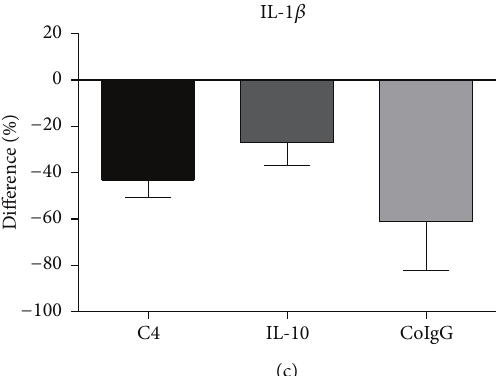
Figure 5: Butyrate transcriptionally influences cytokine responses to Mtb, possibly mediated through IL-10. (a) Cytokine gene expression levels in PBMCs preincubated with 50 𝜇 M C4 for 1 h prior to stimulation with Mtb lysate or LPS for 4 h, as measured by qPCR. The box plot represents median with first and third quartiles; the whiskers represent minimum and maximum values. 𝑛 = 6 to 10, using Wilcoxon signed- rank test, representative of 2+ independent experiments. ∗ 𝑝 < 0.05 . (b) To block translation, PBMCs were preincubated with cycloheximide (CHX) for 1h prior to 1h incubation with C4 (50 𝜇 M). TNF- 𝛼 transcript levels were measured by qPCR 4 h after stimulation with Mtb lysate or LPS. Data are single values ( 𝑛 = 6 to 7), using Wilcoxon signed-rank test, representative of 3 independent experiments. ∗ 𝑝 < 0.05 . (c) To block IL-10 activity, PBMCs were preincubated with IL-10 and C4 (50 𝜇 M) for 1h. IL-6, TNF- 𝛼 , and IL-1 𝛽 production was measured by ELISA after 24 h of stimulation with Mtb lysate. Data are means ± SEM ( 𝑛 = 10 to 12), using Wilcoxon signed-rank test, representative of 4 independent